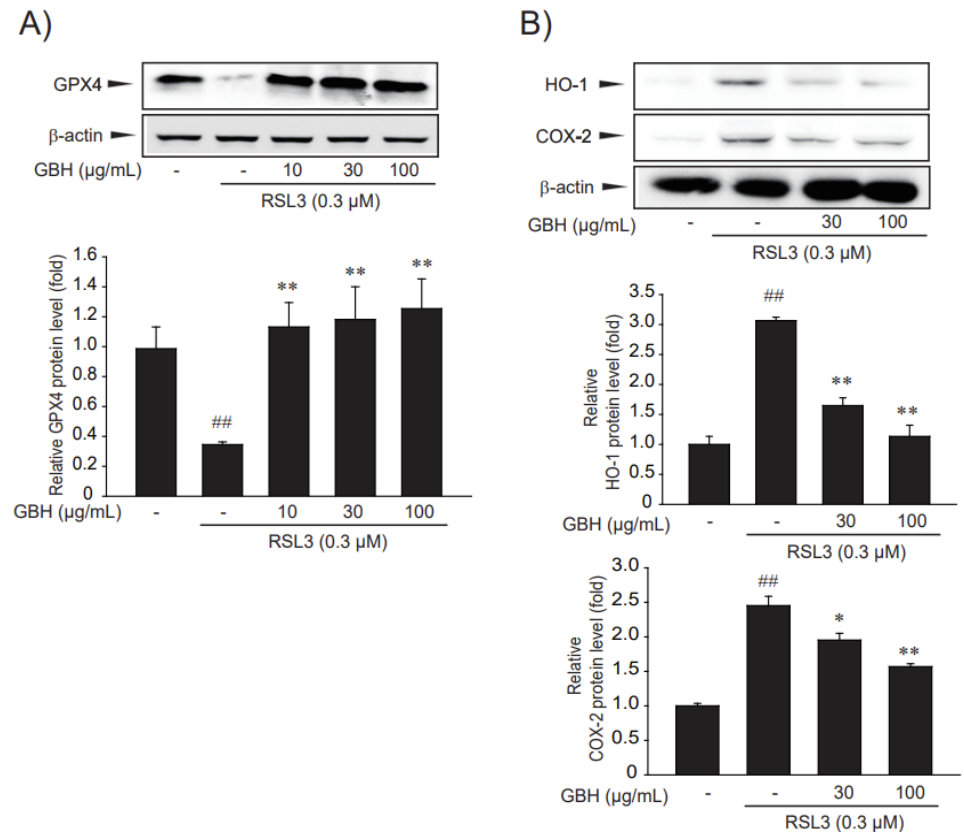
Figure 4. The efficacy of GBH about restored expression of ferroptosis markers in RSL3-induced HT22 cells. ( A , B ) The expression of ferroptosis marker proteins, such as GPX4, HO-1 and COX-2, altered due to RSL3. The HT22 cells were pretreated with GBH(GBH) for 1 h and incubated with 0.3 µM RSL3 and/or GBH for 3 h. Protein expressions of GPX4, HO-1 and COX-2 were detected by immunoblot analysis. Data represent the mean ± S.E. of 3 experiments; * p < 0.05, ** p < 0.01, meaningful versus vehicle-treated control; ## p < 0.01, meaningful versus RSL3 alone.